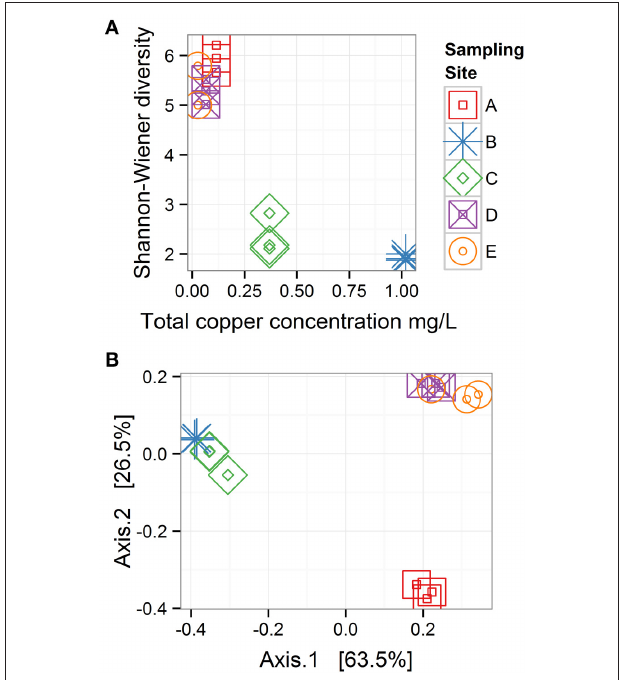
FIGURE 5 | Bacterial diversity across sampling sites. (A) Within-sample diversity ( α -diversity) is measured with the Shannon-Wiener index. (B) Between-sample diversity ( β -diversity) is measured with weighted UniFrac distances and represented with a principle coordinates analysis plot, in which 63.5 and 26.5% of the variability among samples is projected on Axis 1 and 2, respectively; n = 3 for all sampling sites. These plots show when copper concentrations were high (Sites B and C), α diversity was low, and bacterial communities recover in α -diversity after copper concentrations decline, but community composition does not return to the pre-copper